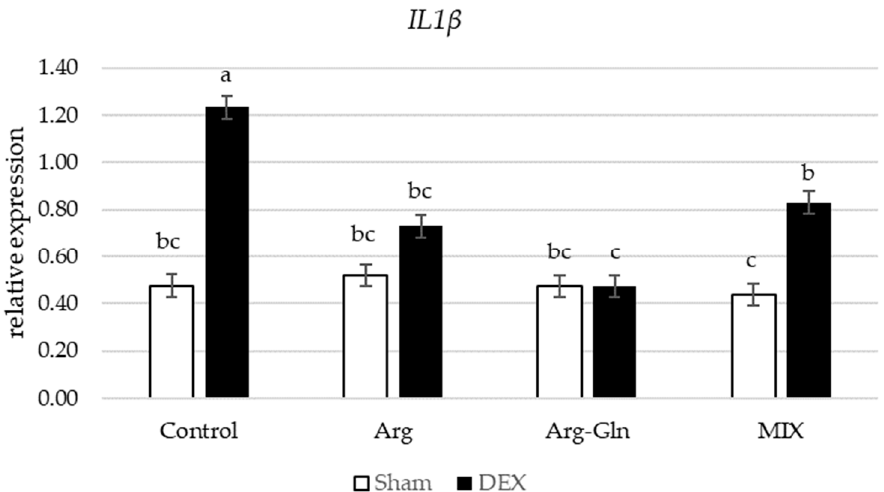
Figure 3. Interaction between diet and dexamethasone for relative mRNA expression of Interleukin-1 β ( IL1 β ). abc Bars not sharing the same letter differ significantly ( p < 0.05). Error bars represent pooled standard error. DEX: Injected with dexamethasone; Sham: Injected with saline solution. Table 8. Relative gene expression of MUC-2, immune-related mechanistic genes and mTOR in ileum of broilers (day 21) subjected to dexamethasone (DEX) or sham injections (experiment 2).